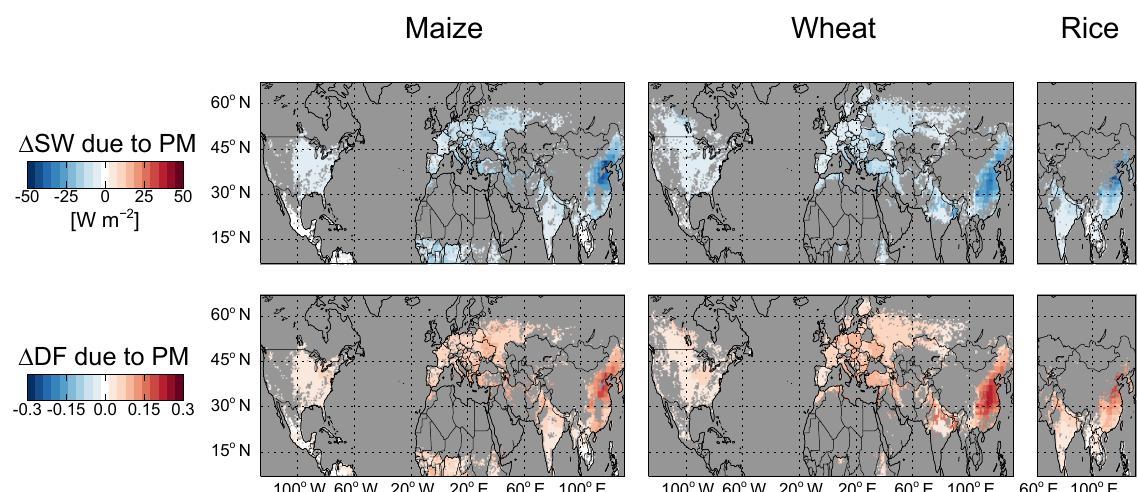
Figure 2. Mean change in daytime (SW > 0) downward SW radiation (top row panels) and DF of the SW radiation (bottom row panels) at the surface due to PM from GC-RT. For pDSSAT growing season (determined by the base simulation) ending in 2010 for maize (left column panels), wheat (middle column panels), and rice (right column panels). Filtered for GAEZ base crop production greater than 0.01Mgkm − 2 .